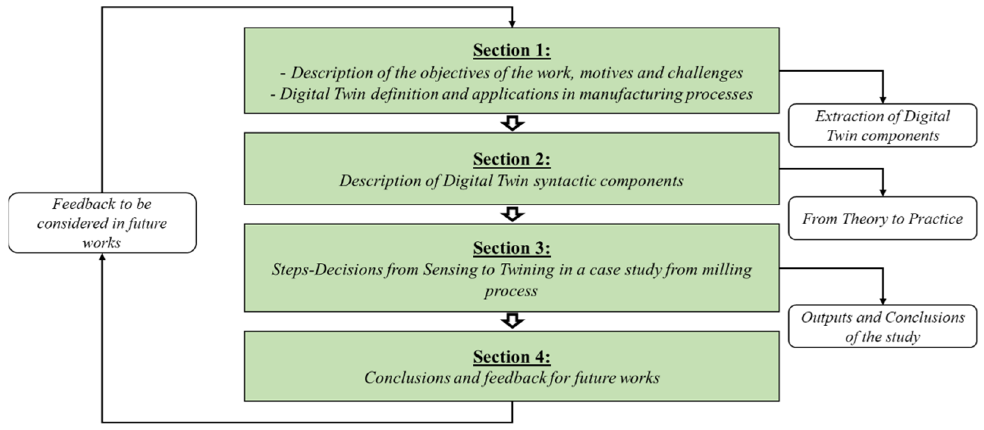
Figure 1. Outline of this